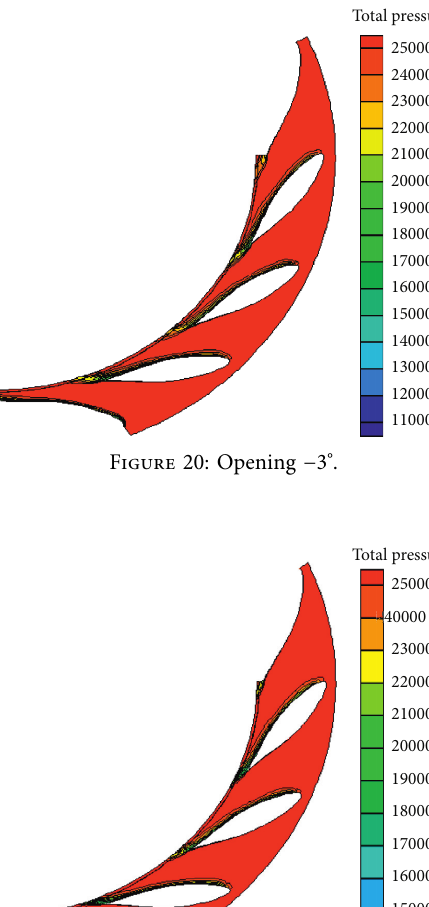
Figure 18: Opening +3 °